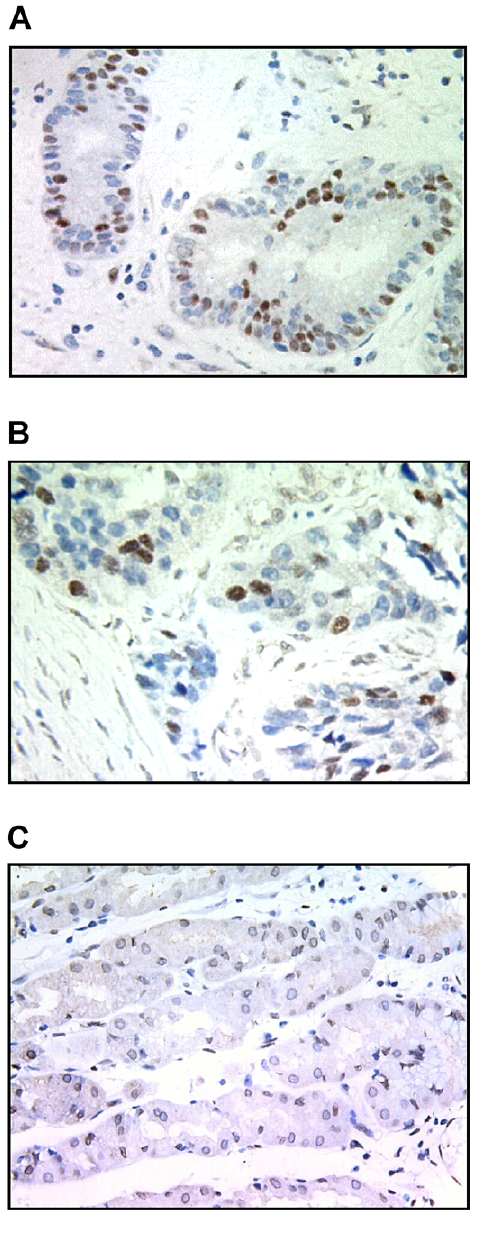
Fig. 2. Immunohistochemical assessment of E2F-1 protein expres- sion in gastric cancer tissues. Five-µm tissue sections were cut from formalin-fixed, paraffin-embedded stomach tumor tissue specimens. Immunohistochemical staining with anti-E2F-1 antibody shows that E2F-1 protein is strongly positive (A), weakly positive (B), or nega- tive (C) in human gastric carcinoma tissues. Representative sections of gastric tumors stained by immunohistochemistry for E2F-1 are shown (original magnification, ×